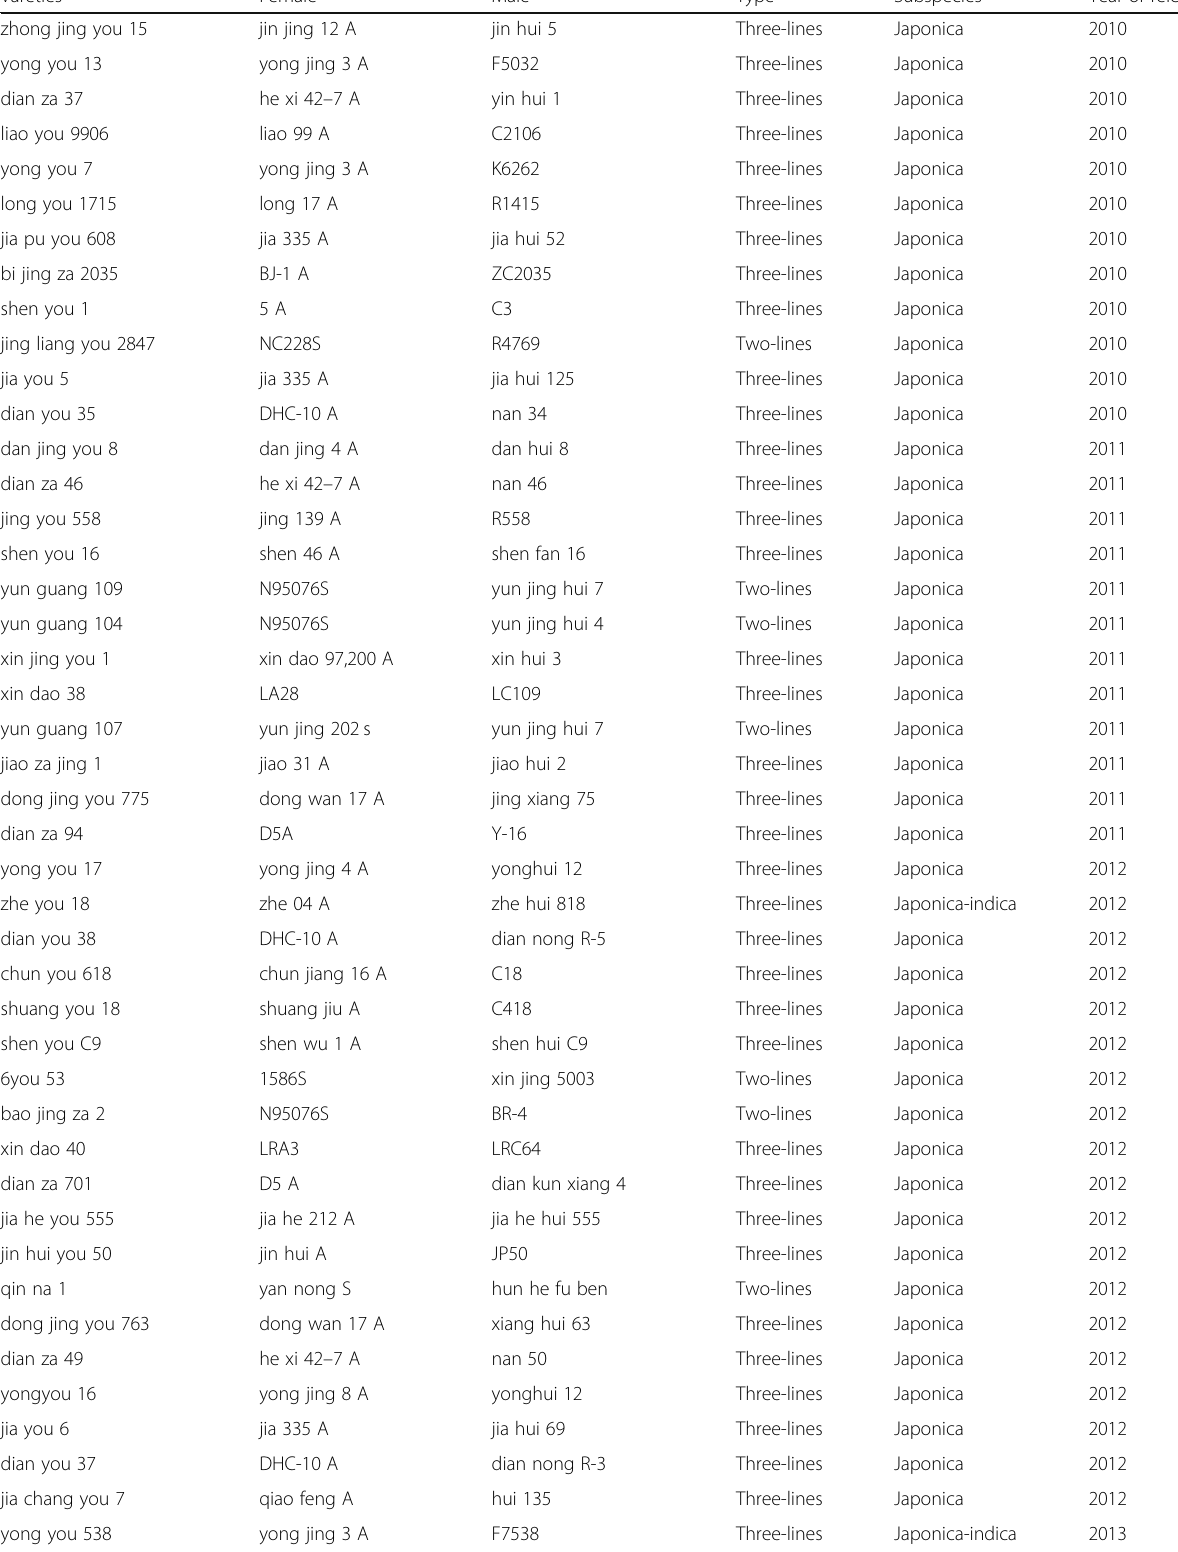
Table 1 List of hybrid japonica rice varieties bred in China (Continued)